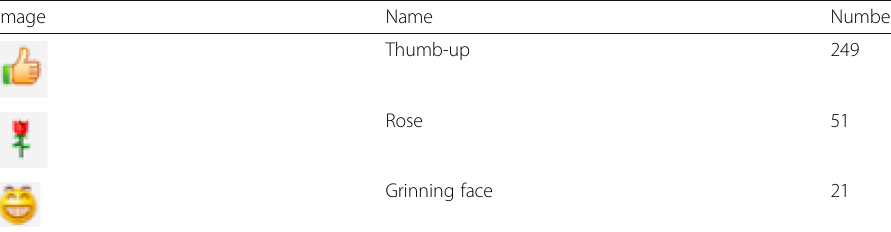
Table 4 Top 3 most frequent Emoji as turn taking/giving